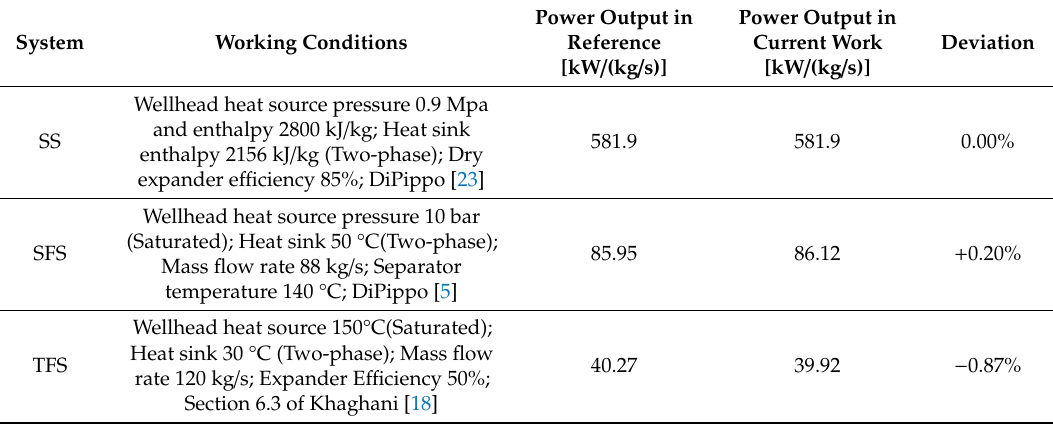
Table 2. Modeling